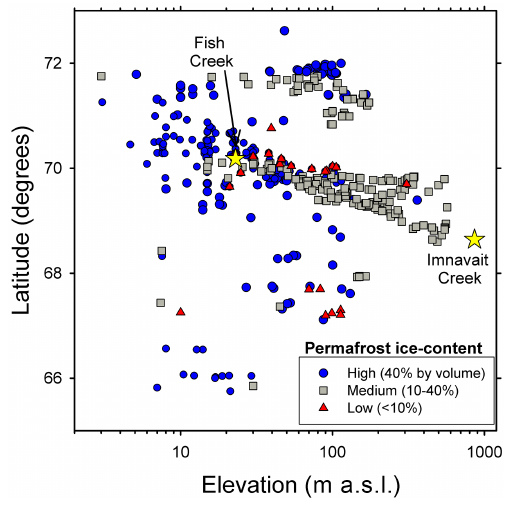
Figure 5. The distribution of beaded stream channels throughout the circum-Arctic in relation to latitude, elevation, and permafrost ground-ice content. Stream networks were identified using imagery in Google Earth in the zone of continuous permafrost where high- resolution imagery was available. The location of streams in the Fish Creek (focus area for this study) and Imnavait Creek (focus area for majority of previous beaded stream research) watersheds are indicated with yellow stars.